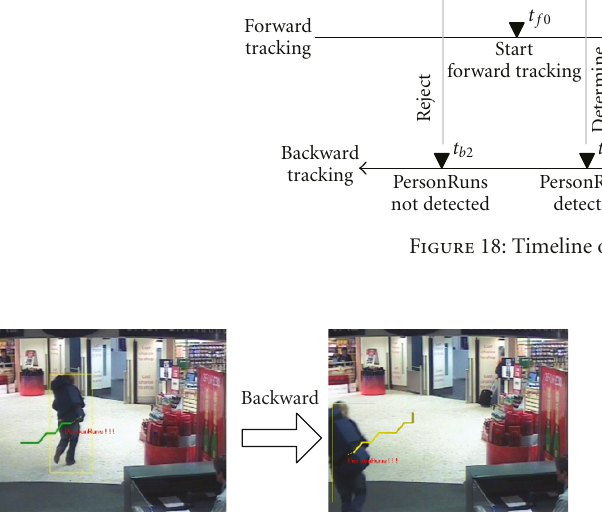
Figure 19: Sample backward tracking trajectory (right).